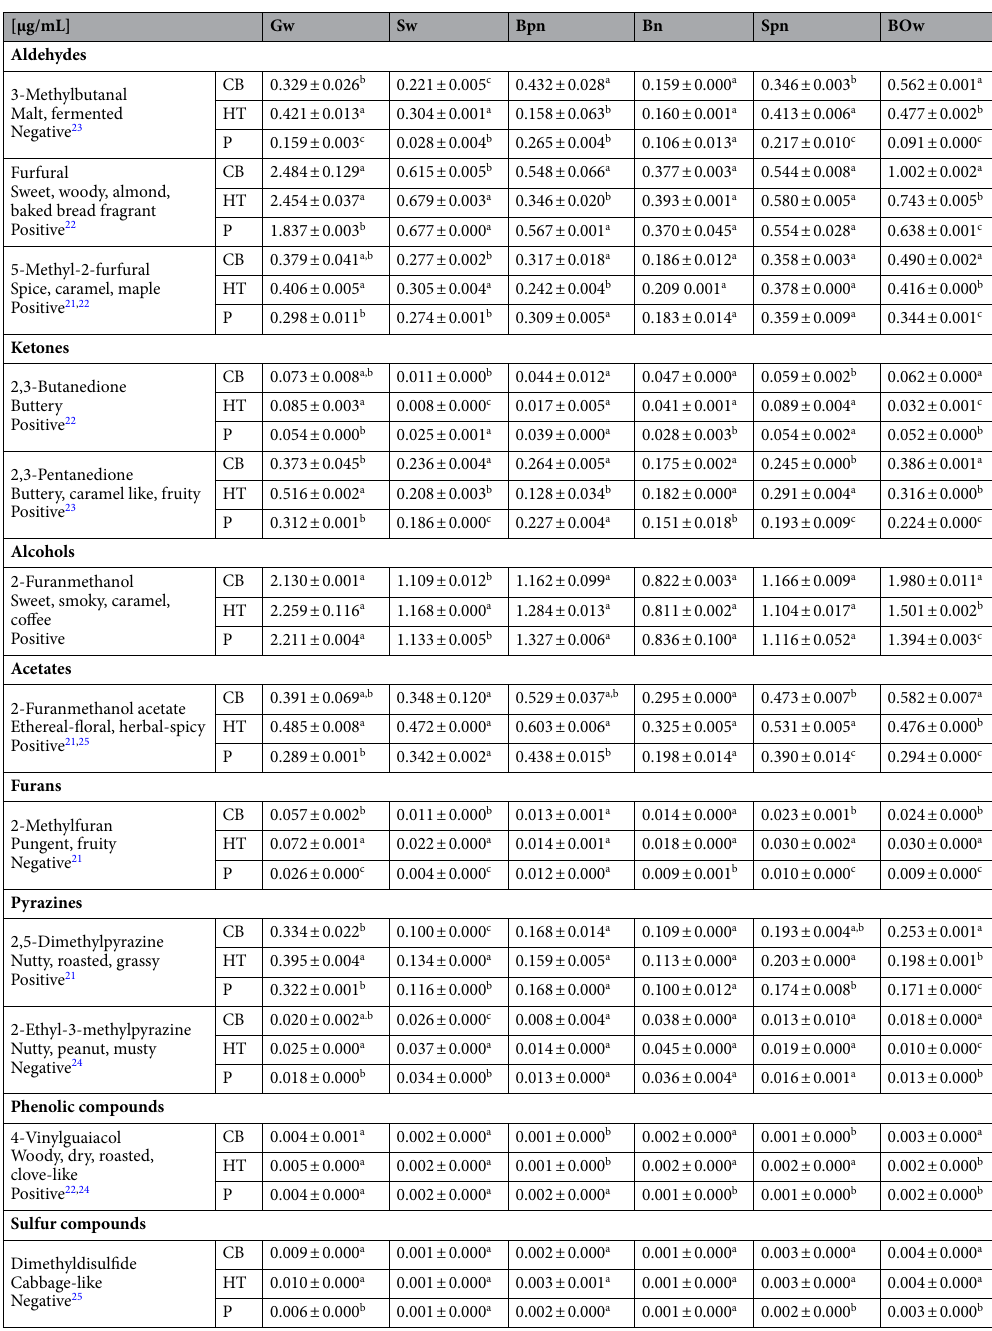
Table 2. Key volatile compounds detected in the coffee brews grouped by chemical class with compared odours and comparison of compounds content in [μg/mL] found in coffee brews via HS-SPME/GC–MS. Mean value ± standard deviation, n = 6. The superscripts a, b, c denote significant (p < 0.05) differences between Hardtank, traditional cold and hot brewing method within the same coffee sample. CB cold brew, HT Hardtank, P Hot brew coffee, Gw Guatemala washed, Sw El Salvador washed, Bpn Brazil pulped natural, Bn Brazil natural, Spn El Salvador pulped natural, Bow Bolivia